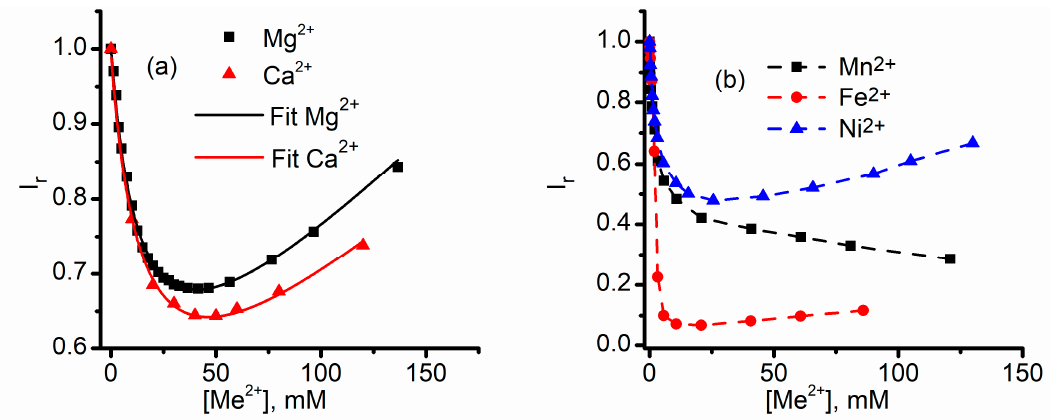
Figure 6. Divalent metal cations induce conformational changes to sub-conducting states. ( a ) The inhibition curves recorded following successive Mg 2+ and Ca 2+ additions indicate that the channels are undergoing transitions to sub-conducting states without full closing. The continuous line represents the fit of experimental data with Equation (1); ( b ) The inflection point in the inhibition curves suggests that other divalent cations also induce transitions to stable sub-conducting states. Adapted from [62] (panel a ) and [61] (panel b ), with permission.